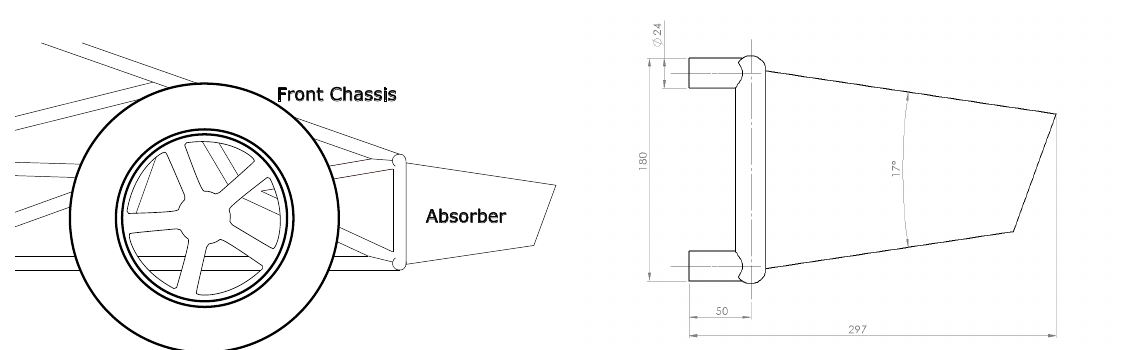
Figure 1. Left : Geometry of the impact attenuator (including part of the chassis). Right : Dimensions of the absorber